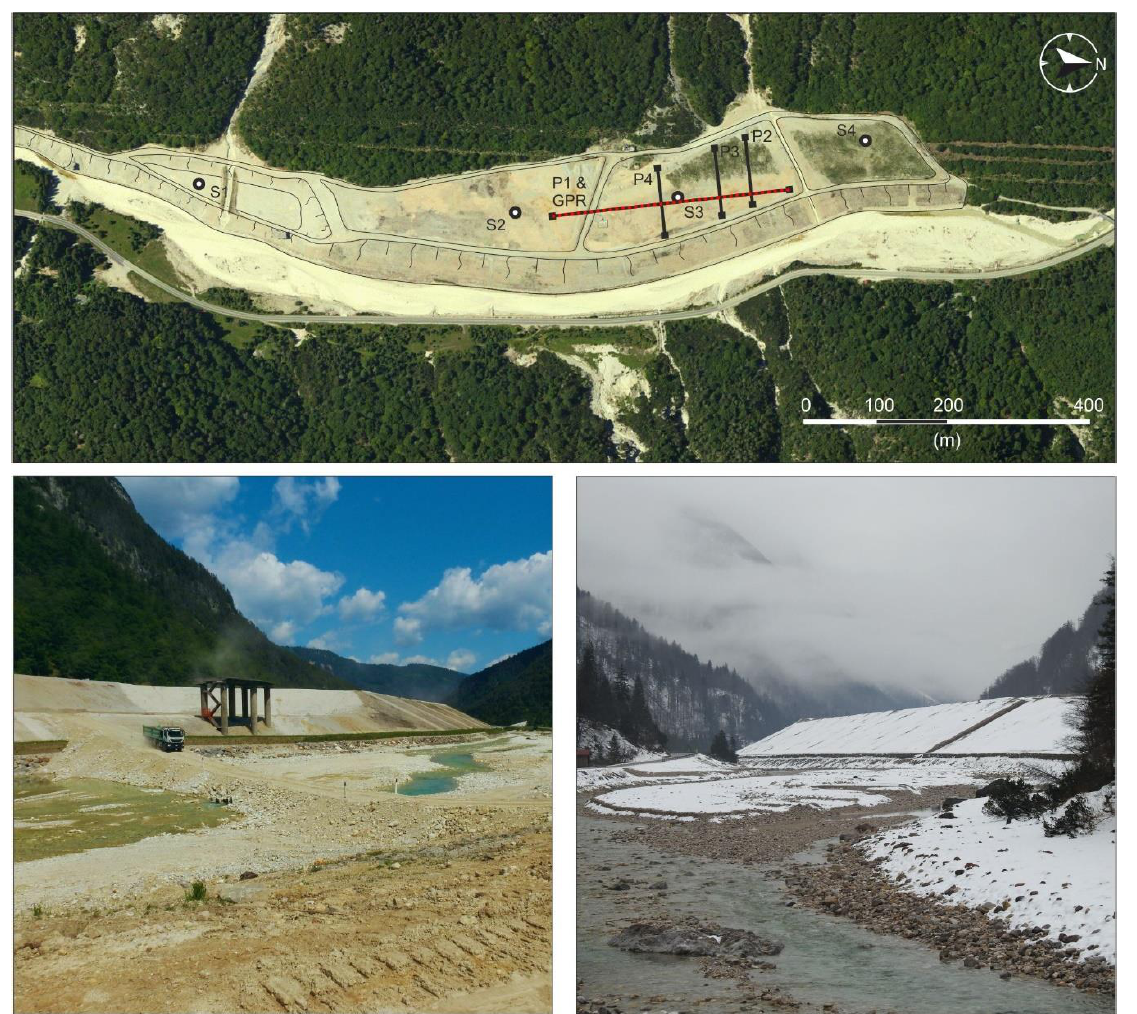
Figure 2. Satellite image showing the extension of the Raibl mine impoundment (above). Labels S1-S4 mark the location of the boreholes used in this study, while the solid black and dotted red lines with labels P1 – P4 depict the ERT and GPR survey locations respectively. The two pictures below show the impoundment as it appears from the Rio del Lago stream bed, from the south (left) and from the north (right).